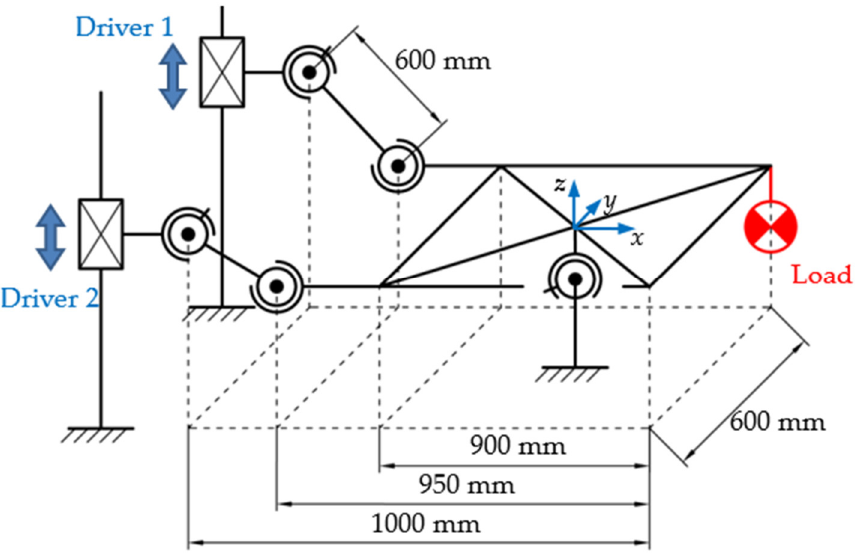
Figure 9. Mechanism diagram of the 2-DOF motion